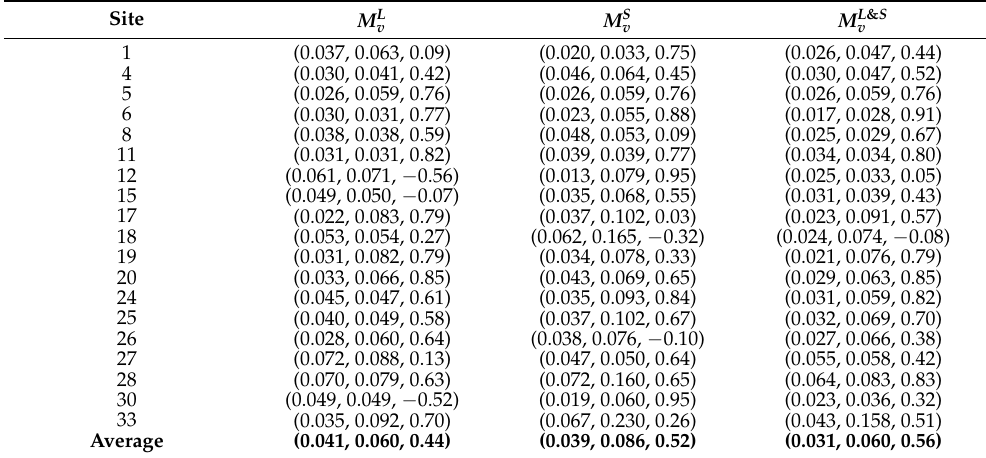
Table 5. Soil moisture retrieval ( Mv ) validation of corn fields; within parenthesis are ubRMSE in m 3 /m 3 , RMSE in m 3 /m 3 and